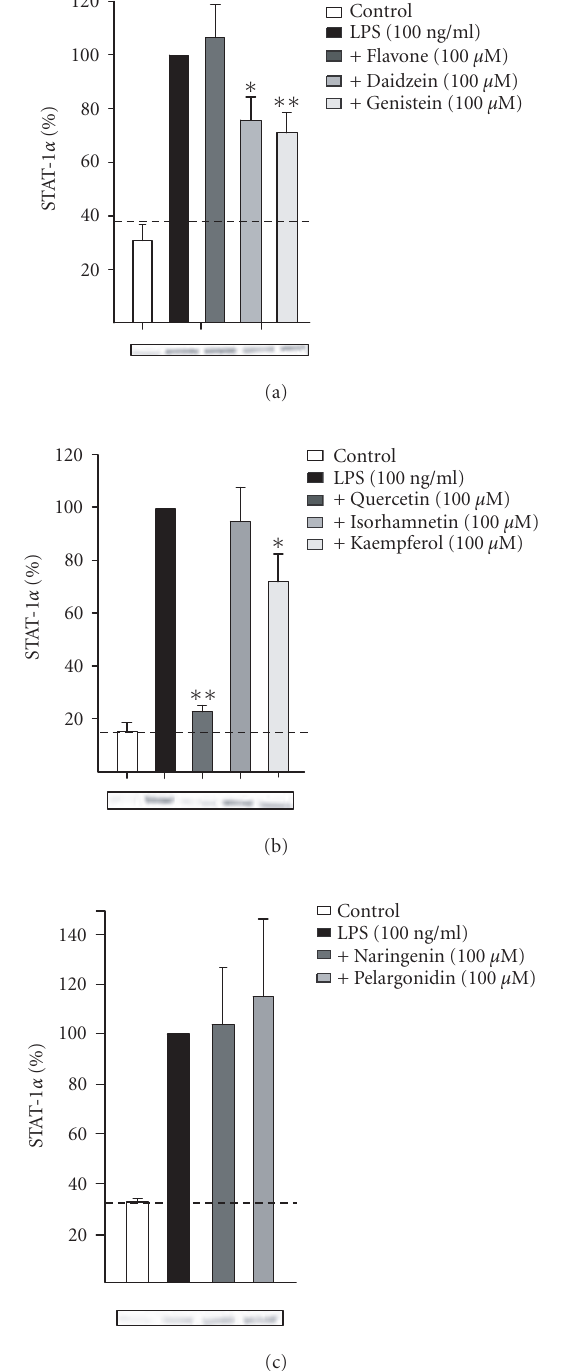
Figure 6: (a)–(c) E ff ects of flavonoids on LPS-induced STAT-1 ac- tivation determined as nuclear translocation of STAT-1 α . J774 cells were incubated for 6 hours with LPS (100ng/ml) or with LPS and the flavonoid (100 μ M), and nuclear proteins were extracted. West- ern blot was used to detect STAT-1 α in the nuclear extracts. STAT- 1 α levels in LPS-treated cells were set at 100% and the other values were related to that. The dotted line represents the nuclear STAT-1 α levels in untreated control cells. Mean + SEM, n = 3, ∗∗ P < . 01, ∗ P < . 05 as compared to LPS-induced